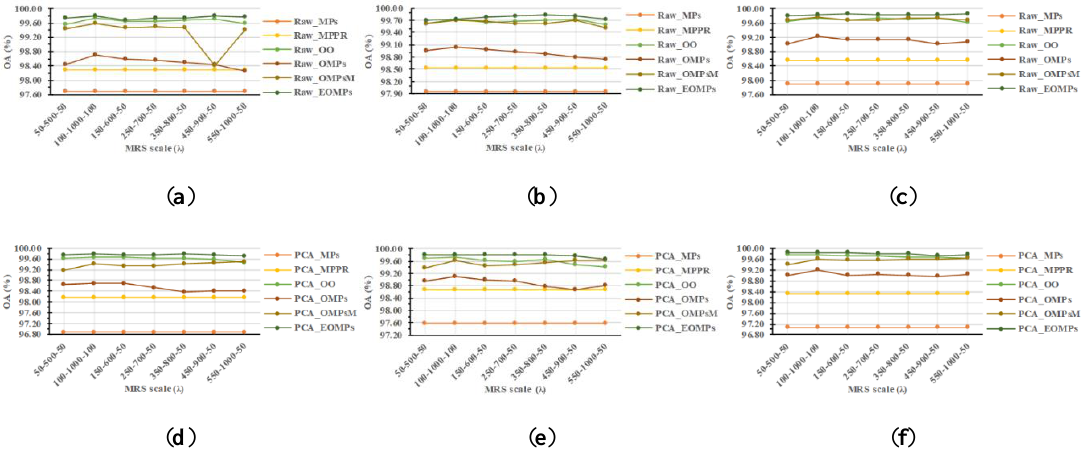
Figure 4. Overall accuracy (OA) values from RaF ( a and d ), ExtraTrees ( b and e ), and END-ERDT ( c and f ) using morphological profiles (MPs) (disk, 1-10-1), MPs with partial reconstruction (MPPR) (disk, 1-10-1), and extended object-guided MPs (EOMP) features extracted from the raw bands.